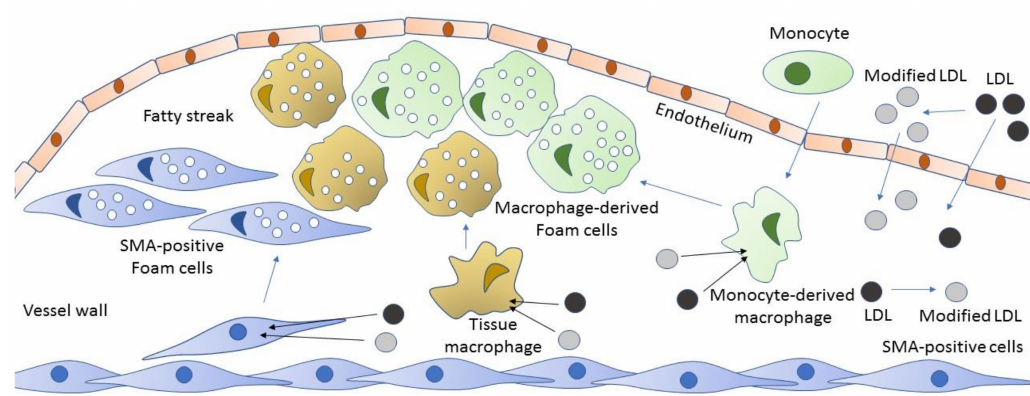
Figure 4. Involvement of subendothelial cells in foam cell formation. From the blood flow, both LDL and modified LDL enter the vessel wall, where they can be internalized by macrophages, pericytes and vascular smooth muscle cells (vascular smooth muscle a-actin (SMA)-positive cells) via scavenger receptors or by phagocytosis or pinocytosis. These macrophages and SMA-positive cells with the taken-up lipid contents in their cytoplasm become foam cells. Adapted from [37], with permission.